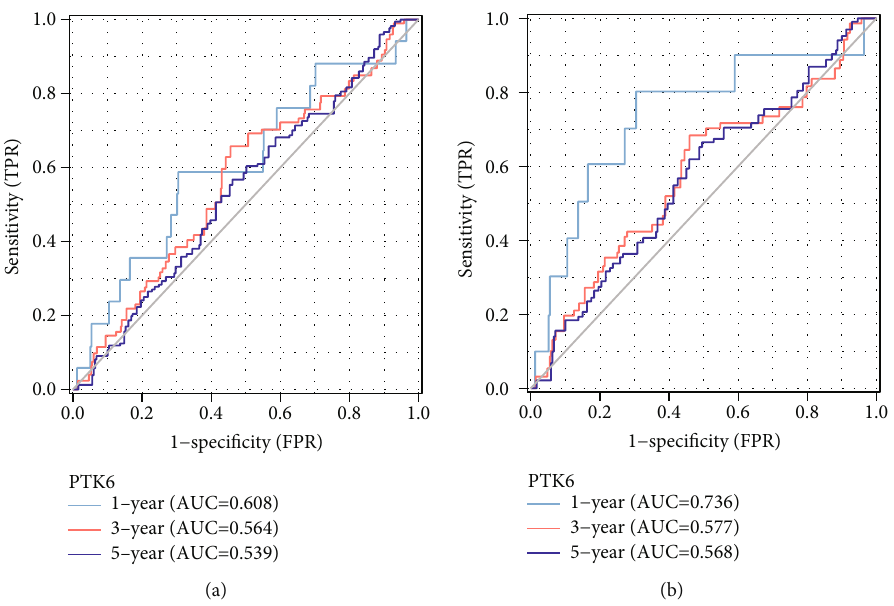
Figure 8: Time-dependent ROC curves of (a) overall survival and (b) disease-speci fi c survival at 1, 3, and 5 years.